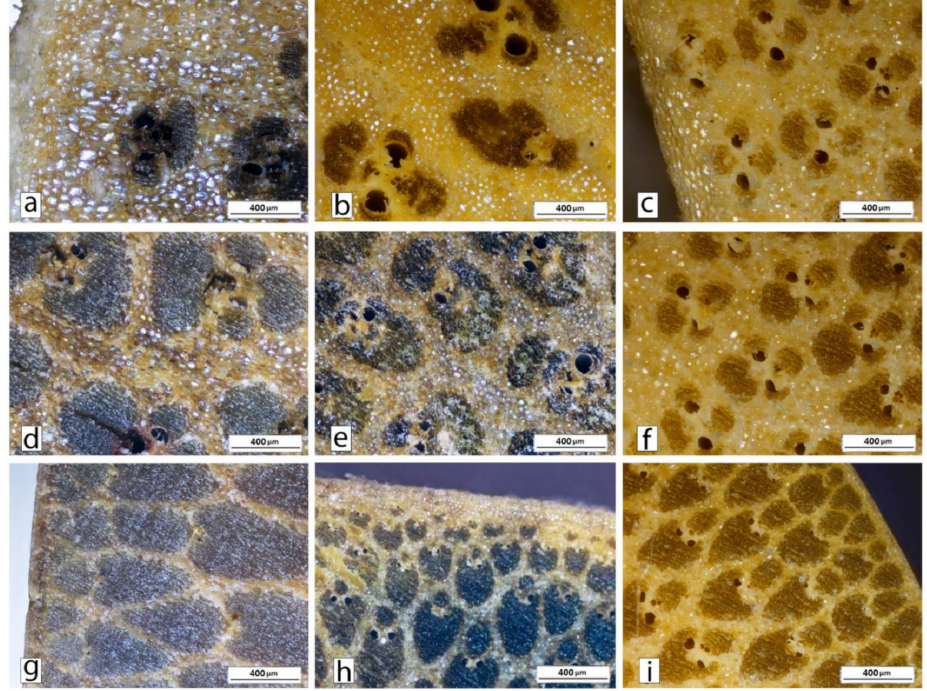
Figure 9. OM images of the inner part of ( a ) AA, ( b ) DS and ( c ) PA species, together with those corresponding to the transition zones of ( d ) AA, ( e ) DS and ( f ) PA species and the corresponding images of the outer parts of ( g ) AA, ( h ) DS and ( i )